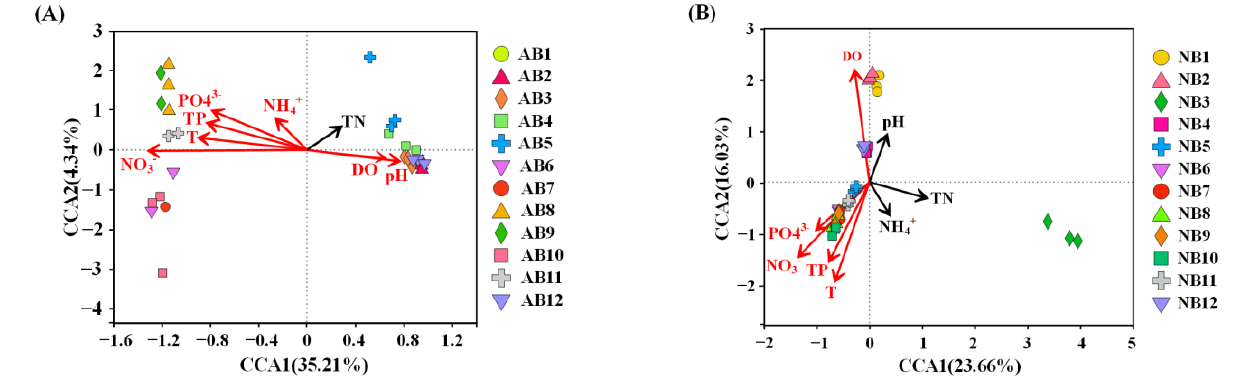
Figure 5. The canonical correspondence analysis (CCA) plot investigates correlations between bac- terial communities and environmental factors at the OTU level. ( A ) B. calyciflorus -associated bacteria community; ( B ) bacterioplankton community. Each significant factor ( p < 0.05) is shown in the plot with red arrows.